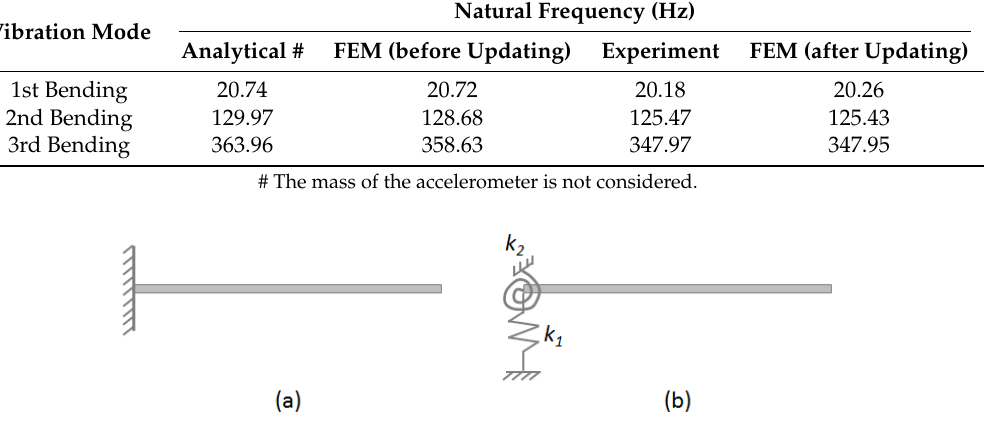
Figure 5. ( a ) Cantilever beam with fixed end; ( b ) cantilever beam supported on two